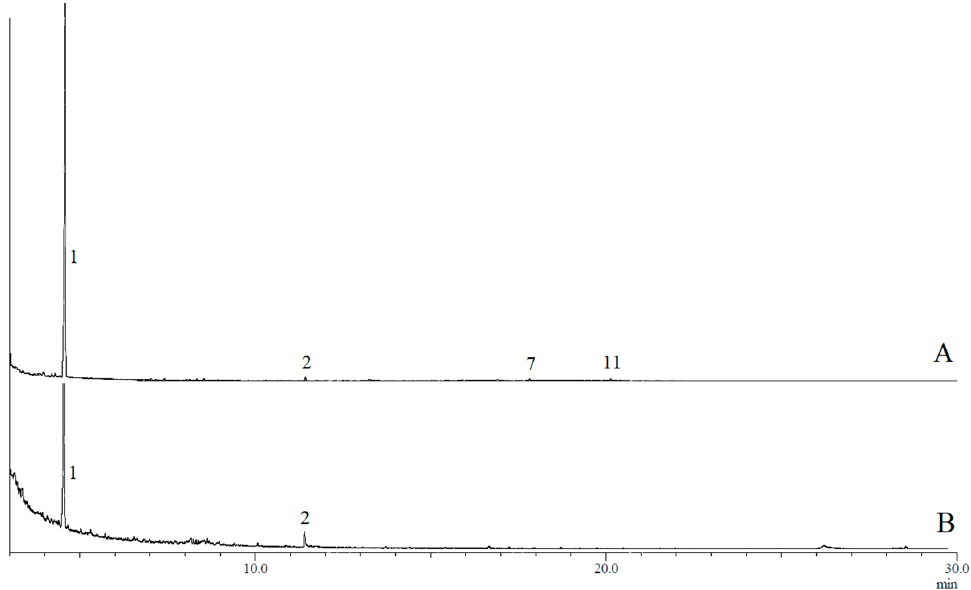
Figure 1. Typical gas chromatogram of ( A ) rectal gland extract and ( B ) headspace collections of B. musae males. Numbered peaks indicate detected compounds: ethyl butanoate ( 1 ), N -(3-methylbutyl)acetamide ( 2 ), ethyl laurate ( 7 ) and ethyl myristate ( 11 ).